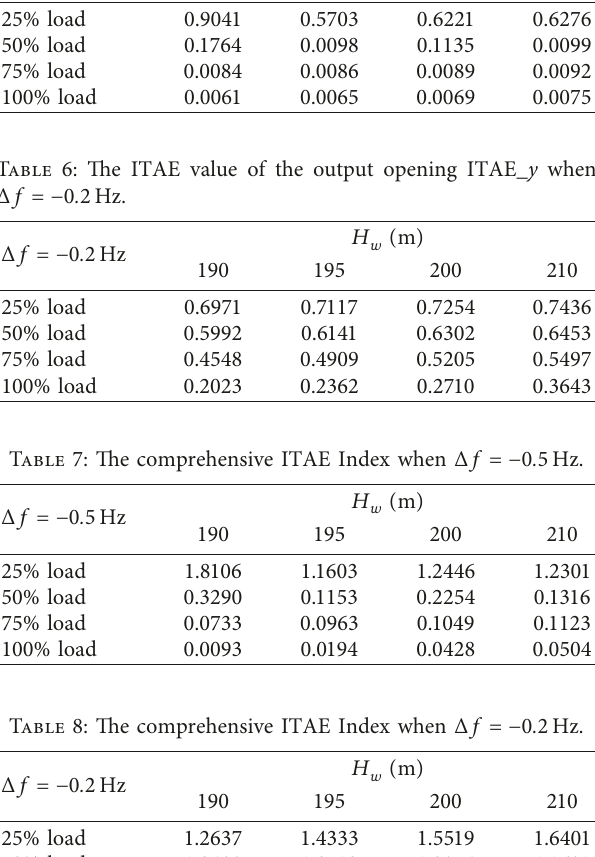
Table 5: The ITAE value of the output opening ITAE _y when Δ f � − 0 . 5Hz. Δ f � − 0 . 5Hz